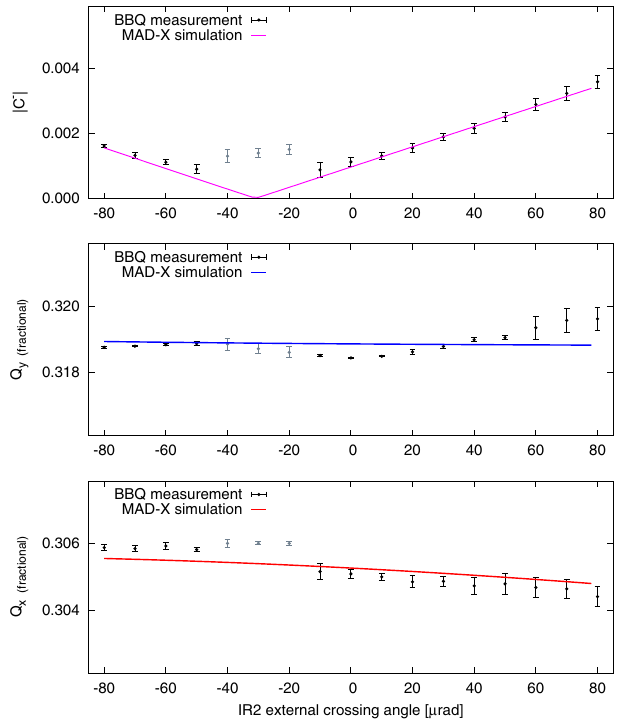
FIG. 5. Modeled and measured tunes and coupling of LHC ¼ 1 m, plotted versus the external crossing angle. beam 2 at β (cid:1) IP 2